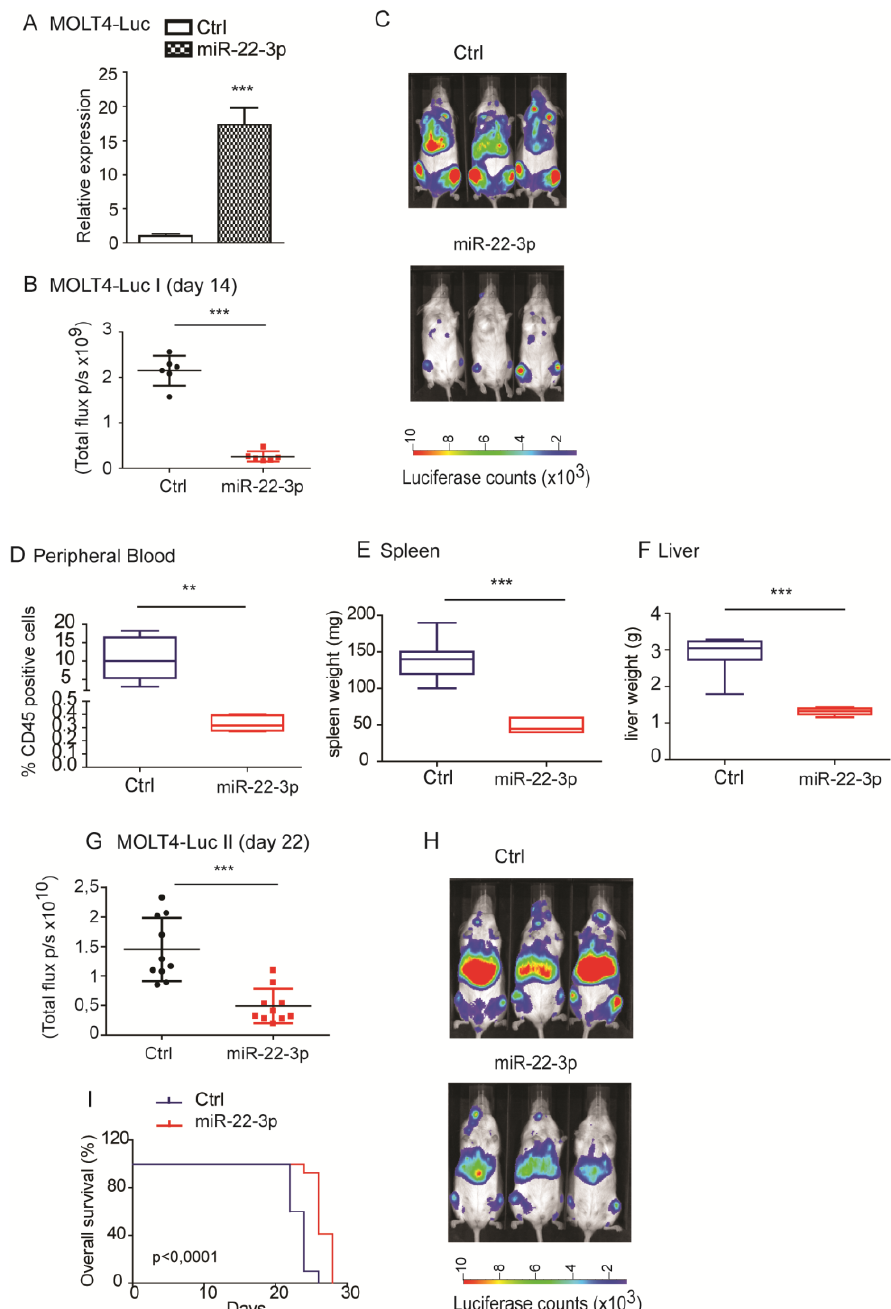
Figure 4. miR-22-3p overexpression in T-ALL cells delays tumor growth in vivo . ( A ) MOLT4 cells expressing luciferase were engineered to stably express miR-22-3p or empty vector (ctrl). ( B , C ) miR-22-3p or empty vector control MOLT4 cells were injected in vivo in NOD.Cg- Prkdc scid Il2rg tm1Wjl / SzJ (NSG) mice ( n = 6). Bioluminescence quantification and representative images of NSG mice at 14 days from injection (*** p < 0.001). ( D – F ) Flow cytometry analysis of human CD45 expression in the peripheral blood, in the spleen, and in the liver at day 21 after injection ( n = 6 Ctrl vs. n = 6 miR-22-3p overexpressing group; ** p < 0.01 and *** p < 0.001). ( G – I ) Bioluminescence quantification and representative images of NSG mice at day 22 after injection ( n = 10 Ctrl vs. n = 10 miR-22-3p-overexpressing group). Overall survival is shown in ( I ) (*** p < 0.001).